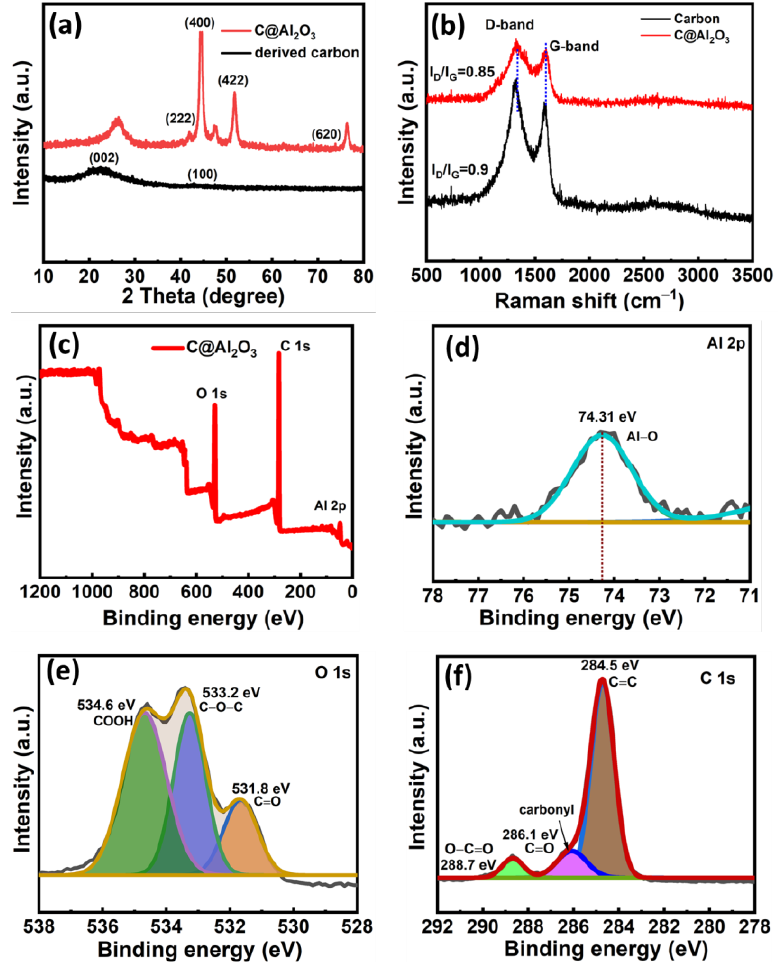
Figure 4. XRD pattern ( a ) of C@Al 2 O 3 , ( b ) Raman shift of derived carbon and C@Al 2 O 3 , ( c ) XPS survey pattern of C@Al 2 O 3 sample, ( d ) Al 2p XPS plot, ( e ) XPS of oxygen (O 1s), ( f ) XPS pattern carbon C 1s.